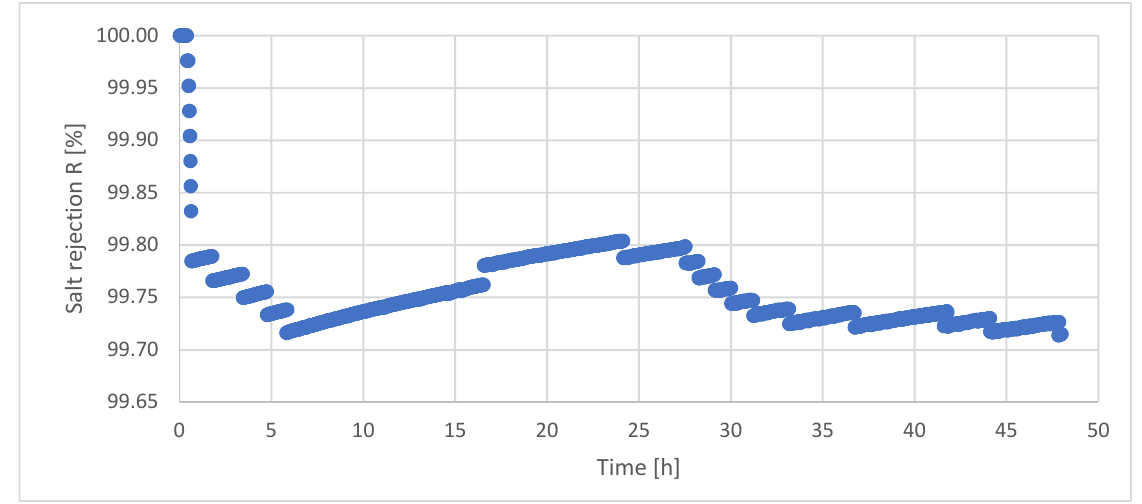
Figure 12. Salt rejection during long-term investigations of AGMD. T F = 64.6 °C, F F = 60 L/h, F K = 130 L/h, T K,in = 16.9 °C. Basically, the salt retention R was permanently above 99.7%.